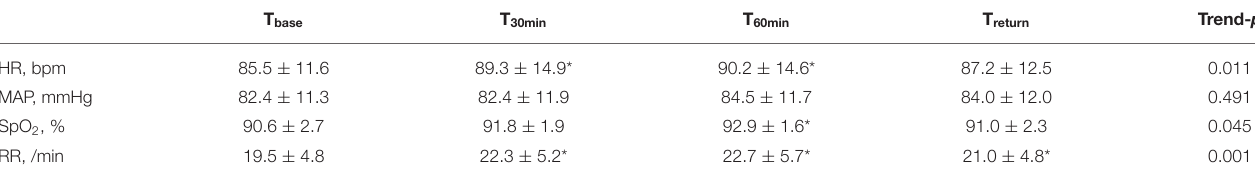
TABLE 2 | Changes of respiratory and hemodynamics parameters at different time points. T base